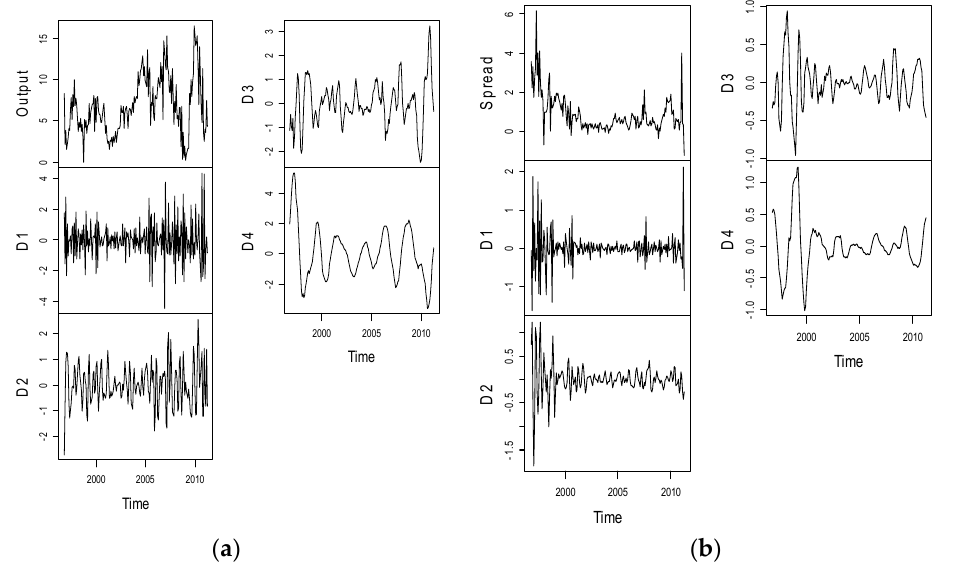
Figure A1. Plot of Output growth, yield spread constructed at the shorter end of yield curve and their corresponding wavelet decompositions. ( a ) Output Growth; ( b ) Sp (1, 3).